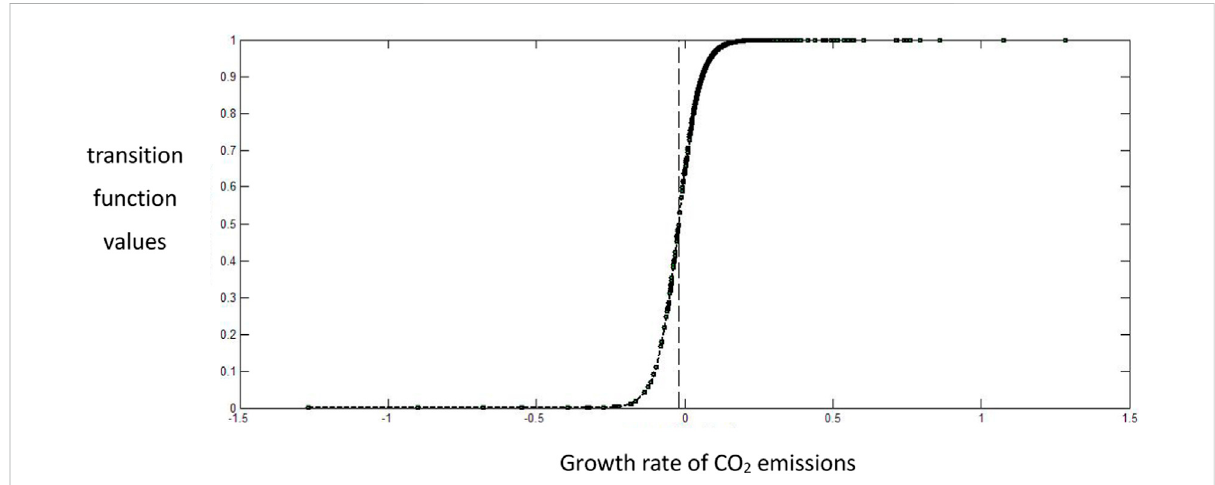
FIGURE 1 The scatter graph of the estimated transition function in the CO 2 emissions growth equation of the logistics